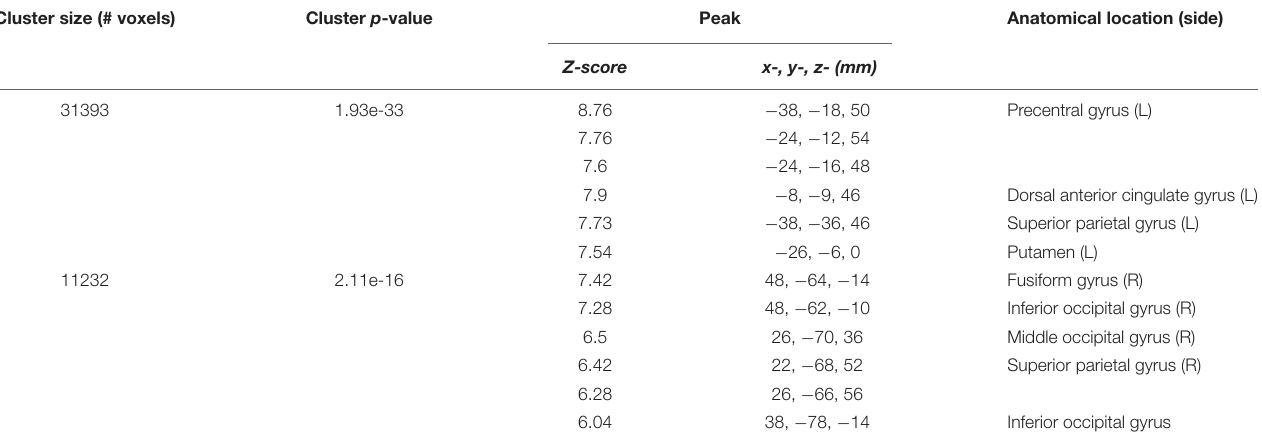
TABLE 2 | Summary of primary fMRI activation clusters during practice (task-related activity).